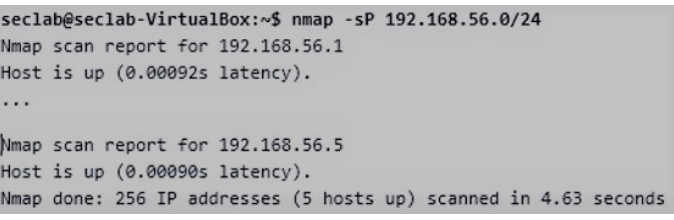
Figure 4. Location of Network Devices with the NMAP